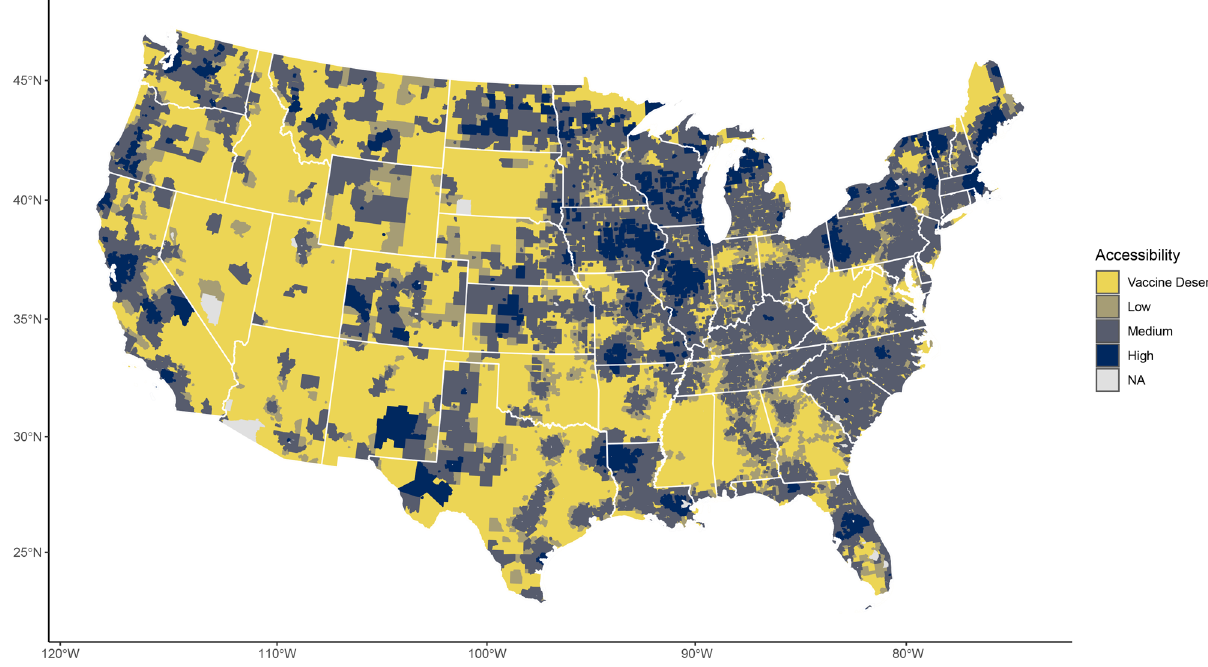
Fig. 3 COVID-19 vaccine deserts and accessibility scores across the US. Map of United States Census tracts colored by their spatial accessibility to COVID-19 vaccine doses. Accessibility scores ( A i ) were estimated by the enhanced two-step fl oating catchment area method. Access strata broadly represent cutoffs suggesting dif fi culty in reaching herd immunity in 8-months (Jan 1 — American Labor Day) with one dose (vaccine desert, A i < 0.85), immunizing all with one dose (low, 0.85 ≤ A i < 1.0), dif fi culty immunizing all with two doses (medium, 1.0 ≤ A i < 2.0), and suf fi cient accessibility (high, A i ≥ 2.0). Under the modeled distribution scheme, if the vaccine sites available to each census tract have a steady supply for the rollout period, they would have a sum (accounting for travel-time decay) of A i doses per person in their respective weighted catchment areas. No estimates (NA) were provided for non-populated census tracts and those ( n = 23) where A i was unde fi